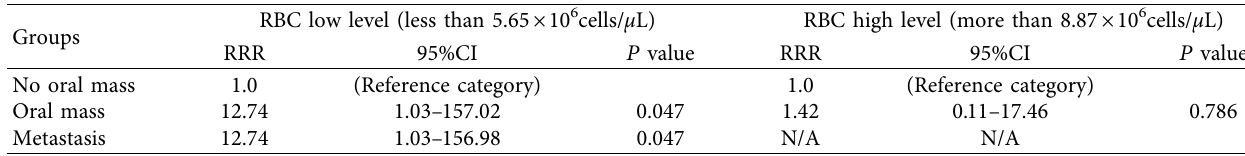
RRR was performed using multinomial logistic regression analysis, P values ≤ 0.05 were considered signifcant, and N/A is not applicable.